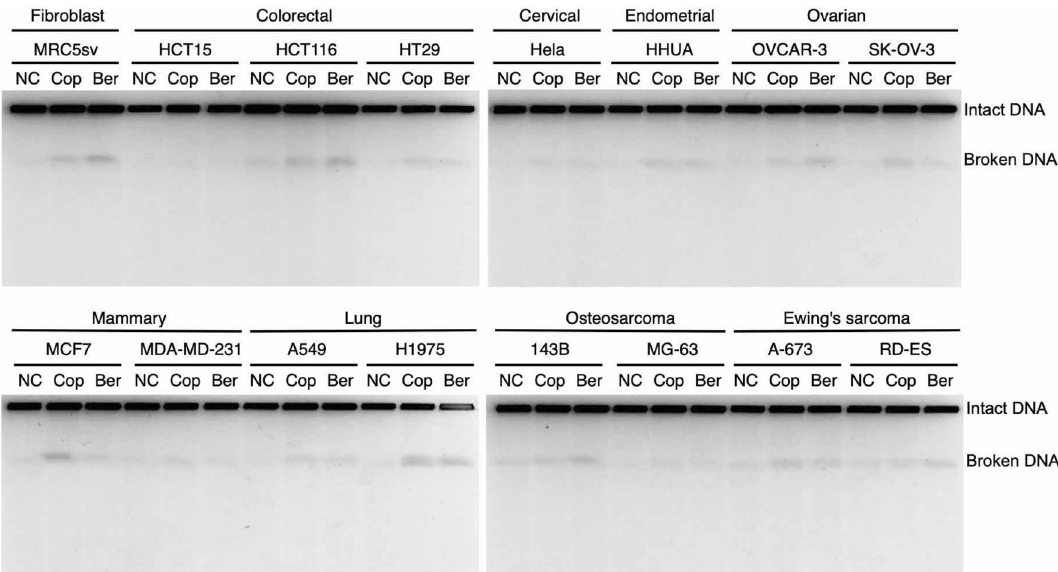
Figure 10. PFGE analysis of DSB accumulation after treatment with berberine and coptisine in various cancer cell lines. Various cancer cell lines were treated with 10 μM coptisine and berberine for 24 h, and the accumulation of DSBs was analysed by